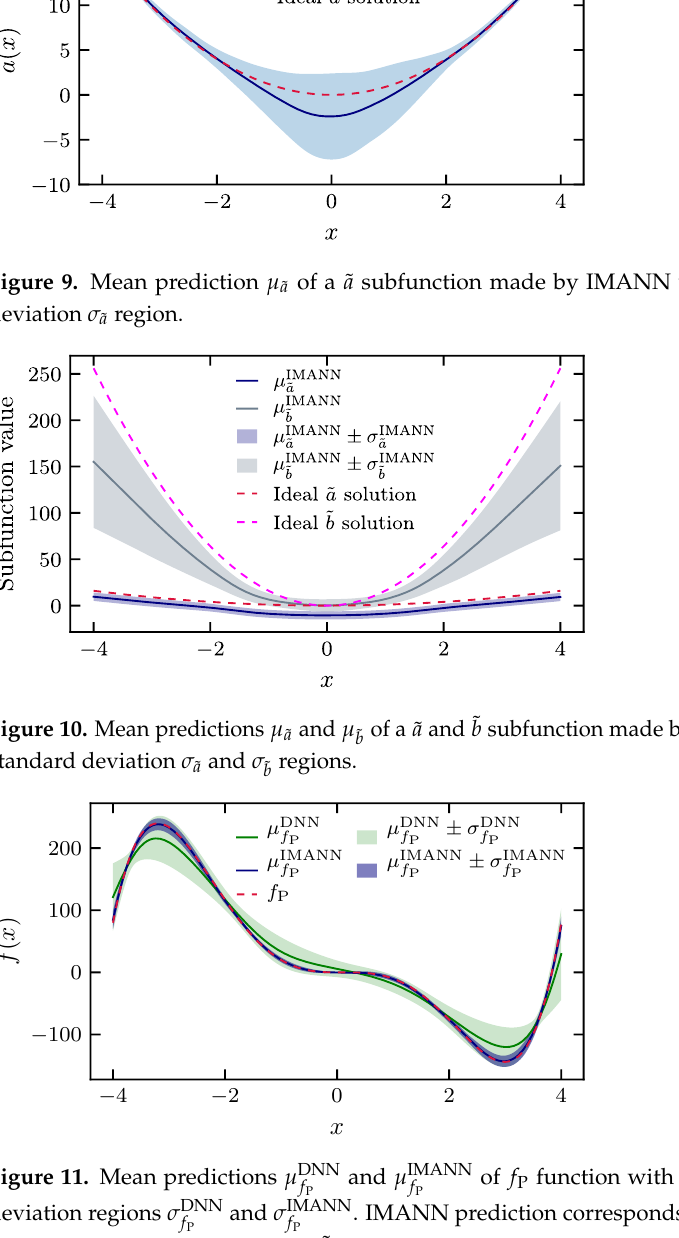
Figure 11. Mean predictions µ DNN and µ IMANN of f P function with corresponding one standard f P f P deviation regions σ DNN and σ IMANN . IMANN prediction corresponds to formulation f 7 , for which f P f P mean values of parameters ˜ a and ˜ b can be found in Figure